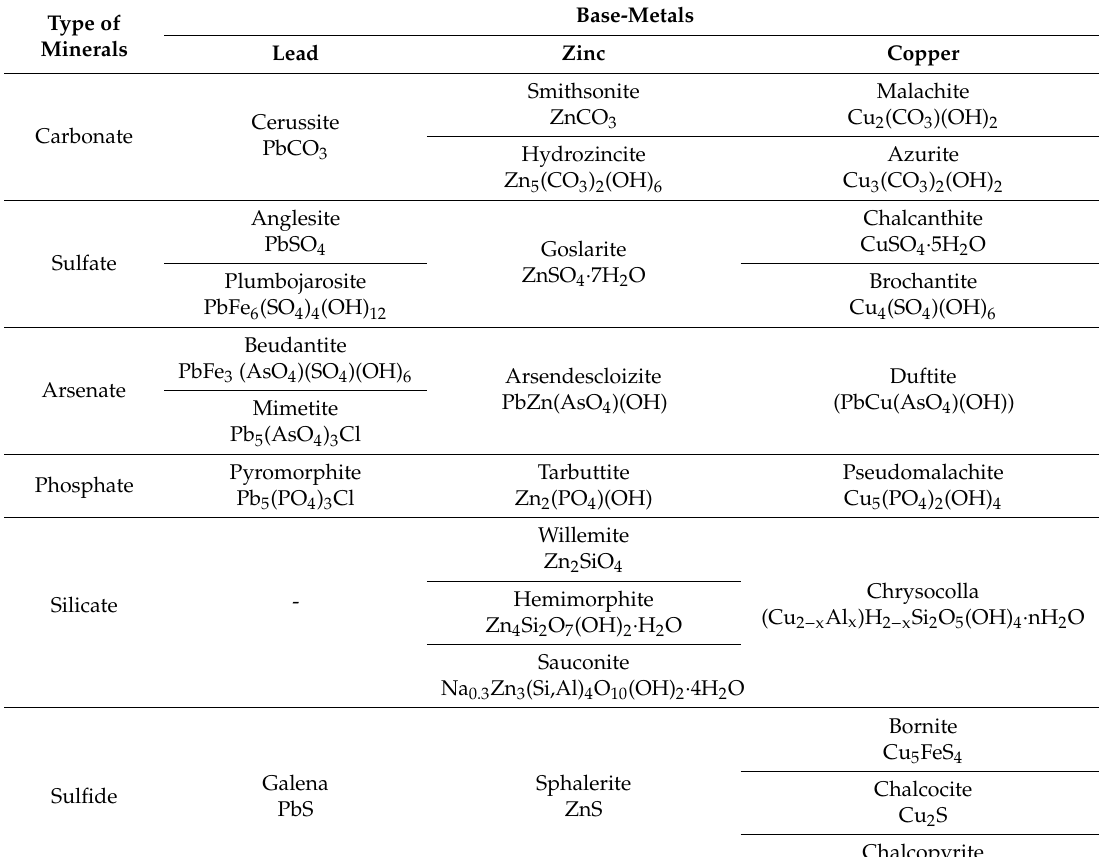
Table 2. Economically-valuable minerals of base-metals, associated with lead vanadate ores [27,29–32]. Type